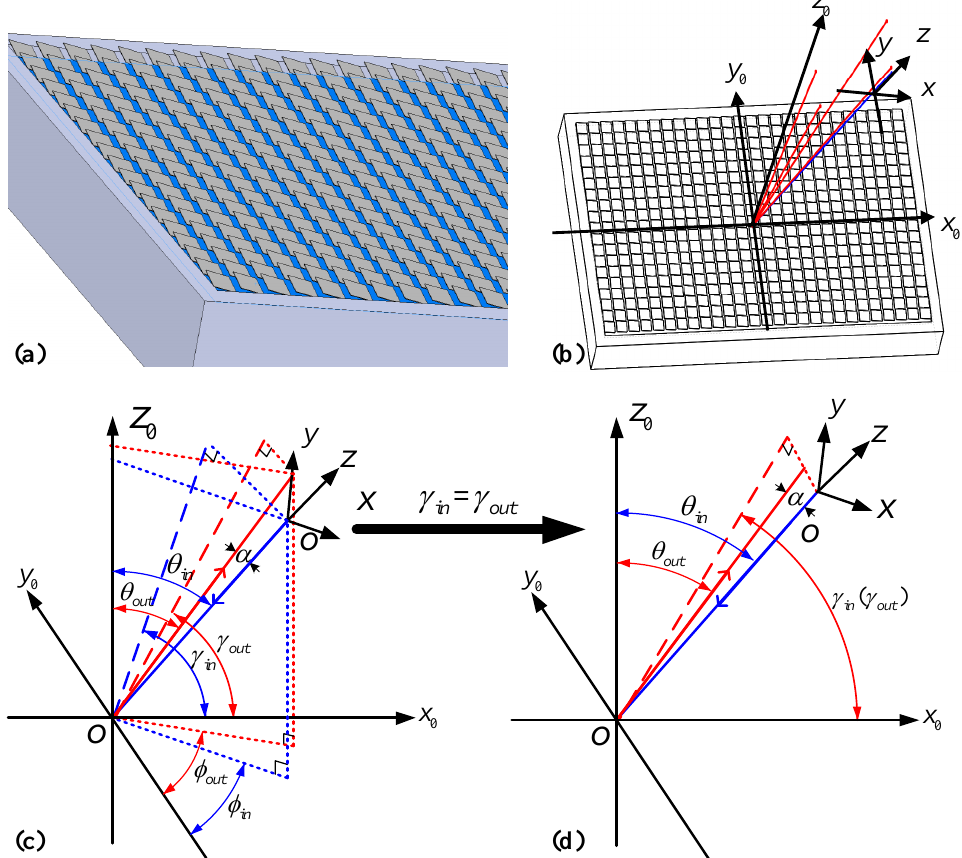
Figure 3. ( a ) Two-dimensional diffraction model of the DMD. ( b ) The incident beam and diffraction beam. ( c ) The coordinate system ( x 0 , y 0 , z 0 ). ( d ) Distribution of the input and output beam when γ in = γ out